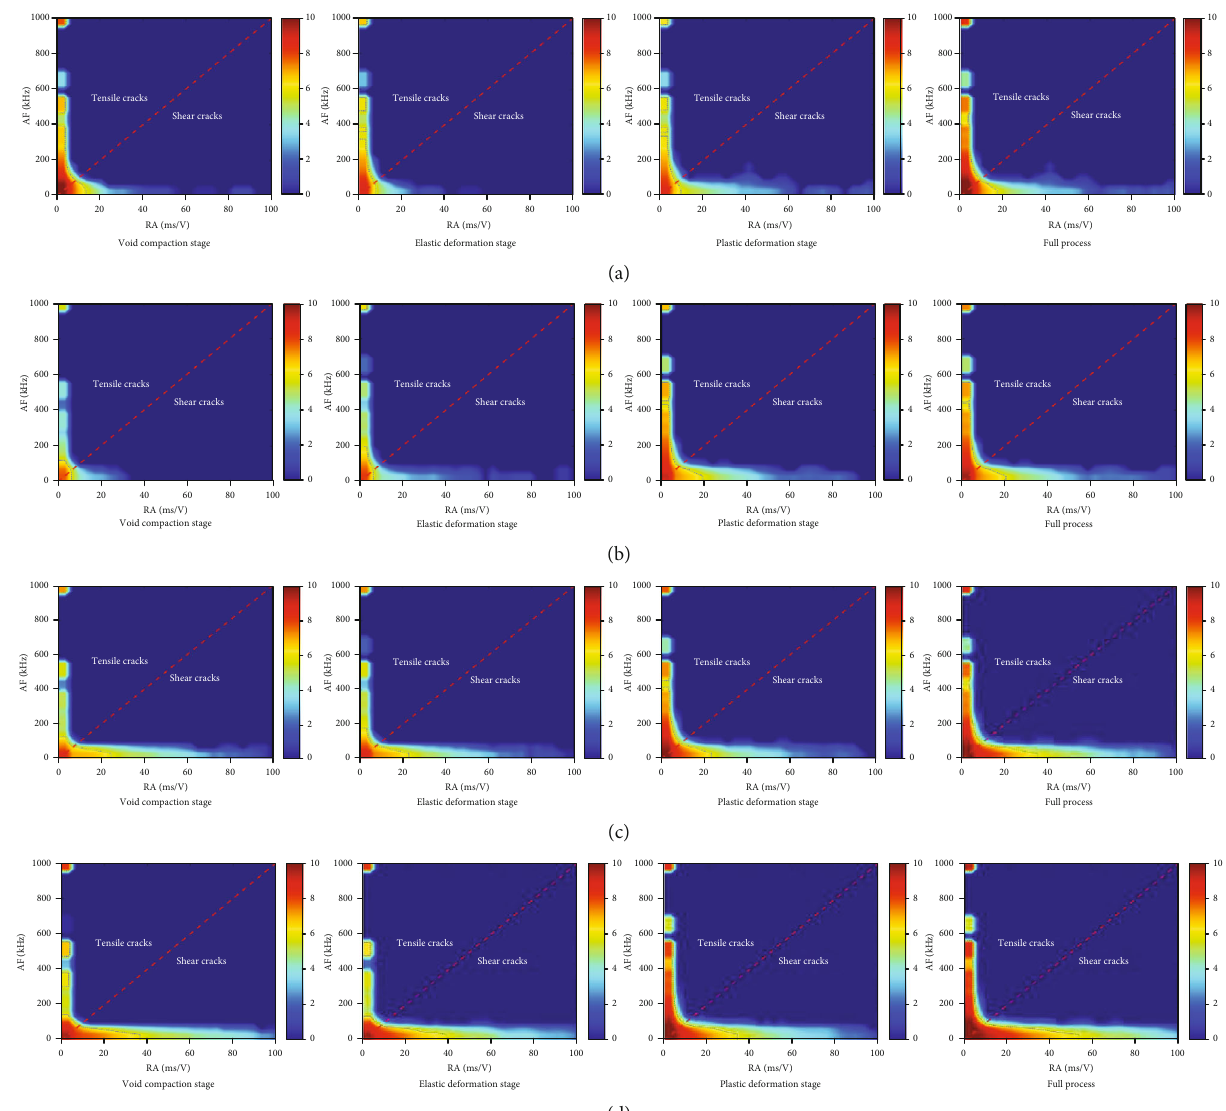
Figure 11: RA-AF relationship under di ff erent moisture content. (a) W0-1, (b) W1-1, (c) W2-1, and (d) W3-1.